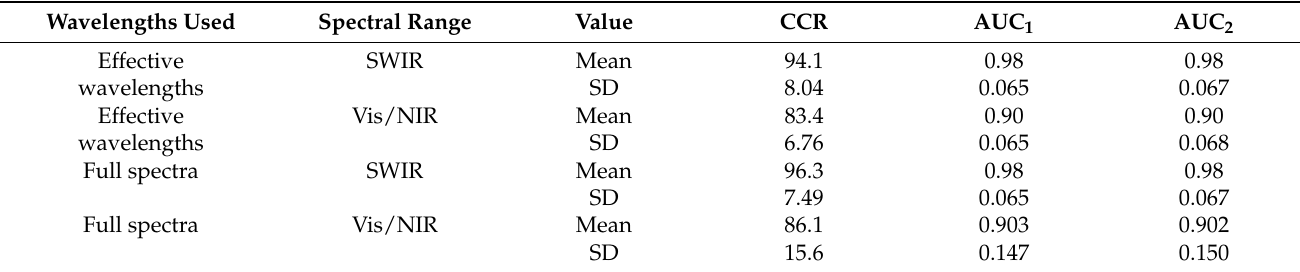
Table 7. Comparison of mean and standard deviation (SD) values of CCR and AUCs of the ensemble classifier using either all the spectral data or using only the selected wavelengths, over SWIR and Vis/NIR spectral ranges. Wavelengths Used Spectral Range Value CCR AUC 1 AUC 2 Effective SWIR Mean wavelengths